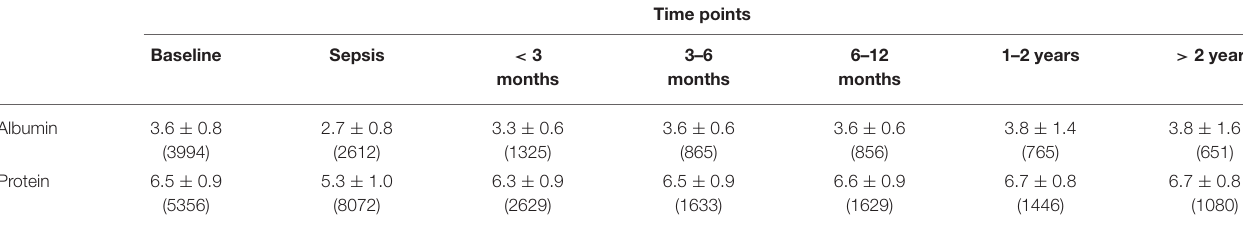
TABLE 4 | Measurement of the synthetic function of the liver in studied time